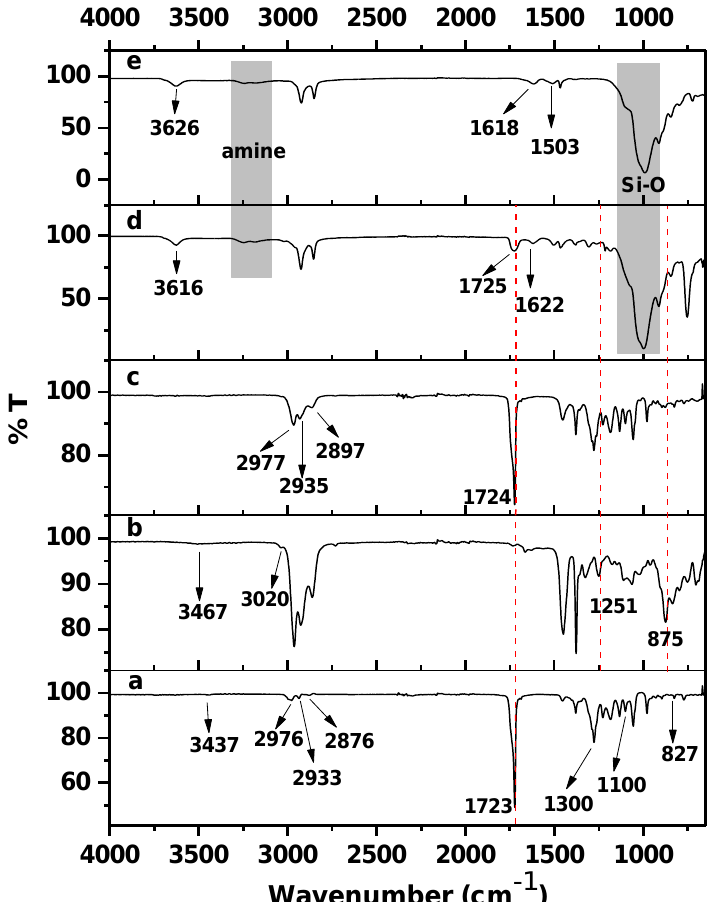
Figure 4. FTIR spectra of ( a ) PHB, ( b ) ENR-50, ( c ) PHB/ENR-50 (50/50)